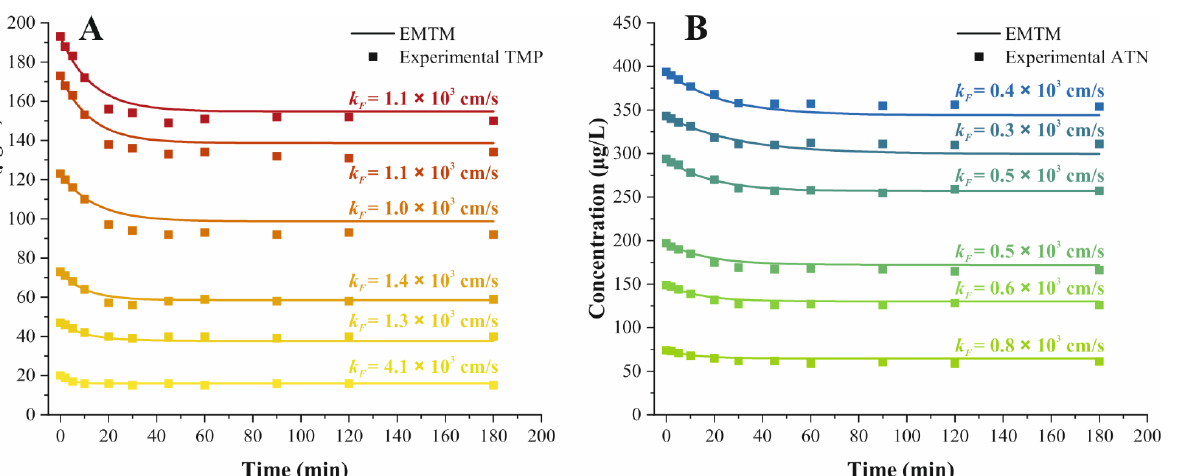
Figure 1. Representative SEM micrographs. ( A ) inside of PPH; ( B ) outside of PPH, at a series of magnifications. ( C , D ) FTIR spectra of TMP ( — ), ATN ( — ), PPH ( — ) and after adsorption of TMP ( — ) or ATN ( — ) on PPH.